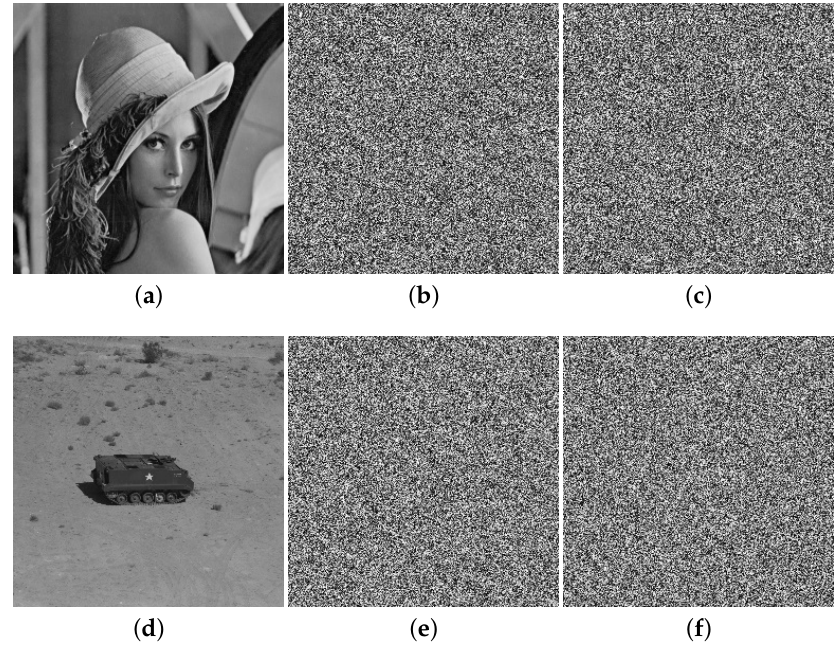
Figure 15. Keys sensitivity: ( a ) lena; ( b ) encrypted lena ( x 0 , µ ) ; ( c ) encrypted lena ( x 0 + ∆ , µ ) SSIM = 0.0081; ( d ) tank; ( e ) encrypted tank ( x 0 , µ ) ; ( f ) encrypted tank ( x 0 , µ + ∆ ) SSIM =